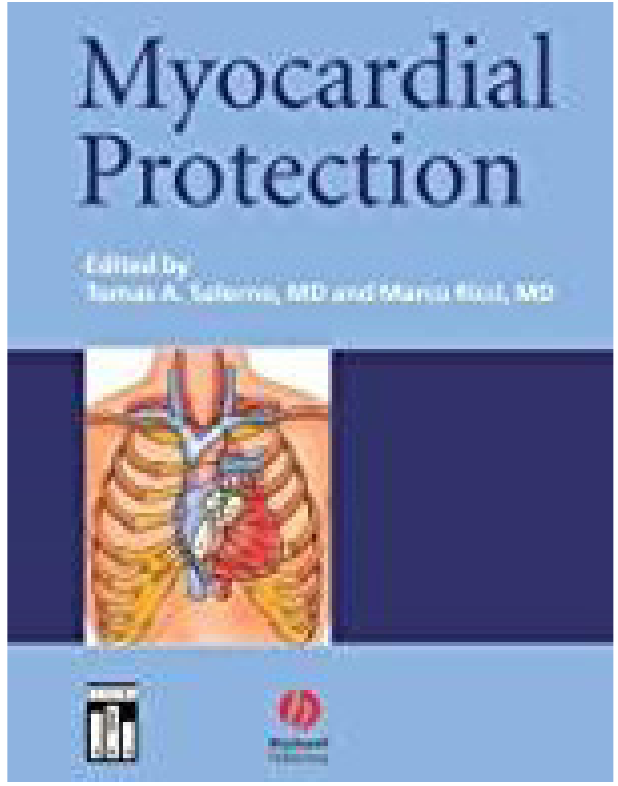
Fig. 11 - Textbook on cardioplegia and myocardial protection by Drs. Tomas A. Salerno and Marco Ricci.